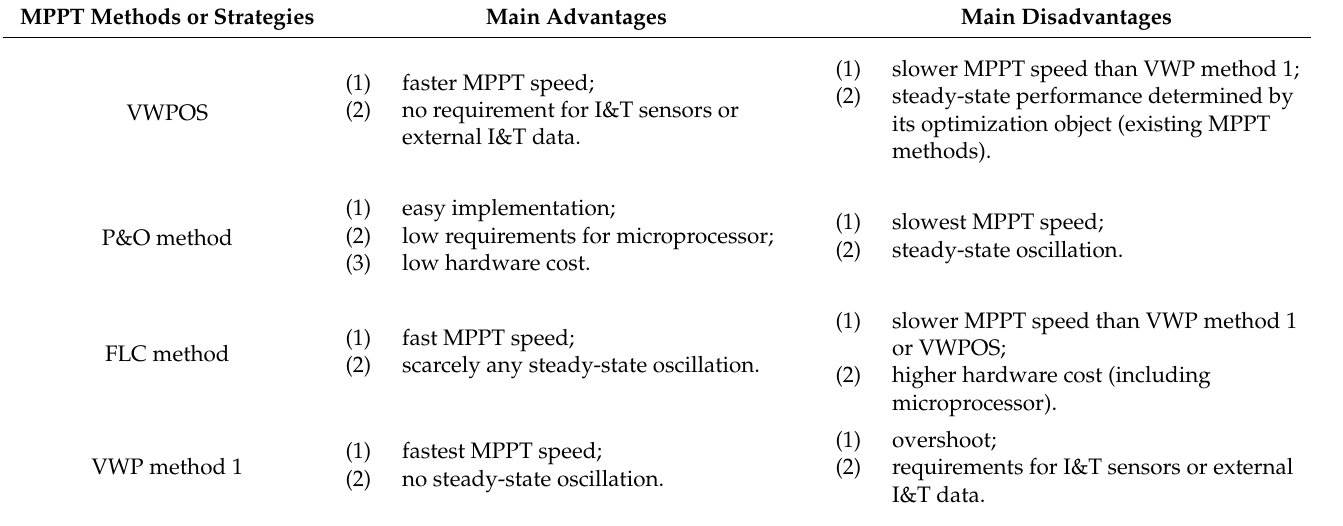
Table 11. Comparison VWPOS with other MPPT